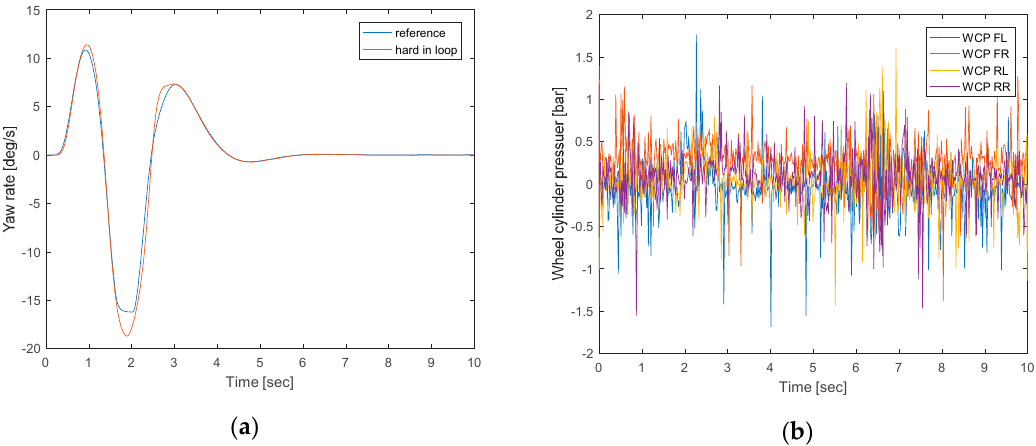
( b ) Figure 20. Test results based on the conventional PID-based controller at 𝑢 = 100 km/h and 𝜇 = 0.8. ( a ) is a comparison of the nominal and actual values of the yaw rate, and ( b ) is the wheel cylinder pressure value collected from the wheel cylinder pressure sensor. In high road adhesion conditions, the actuators controlled by the two controllers hardly trigger work. As far as the yaw rate follows, the controller based on tire force observation has obvious advantages. The test conditions of high and low road adhesion coefficients at a speed of 120 km/h are almost the same as those at a speed of 100 km/h. 5.2. Sine with Dwell Condition The setting of vehicle speed and road adhesion coefficient in the sine with dwell condition in the loop test is consistent with the software co-simulation. The vehicle speed is set to 80 km/h, the road adhesion coefficient is 0.5 and 0.8, and the peak steering angle is 1.5 A, 2 A, 2.5 A,…,6.5 A and 270 deg respectively. Compared with the software co-simulation, as shown in Figures 21–26, firstly, the overshoot caused by the fluctuation of the yaw rate during the steering hysteresis phase of the test of the